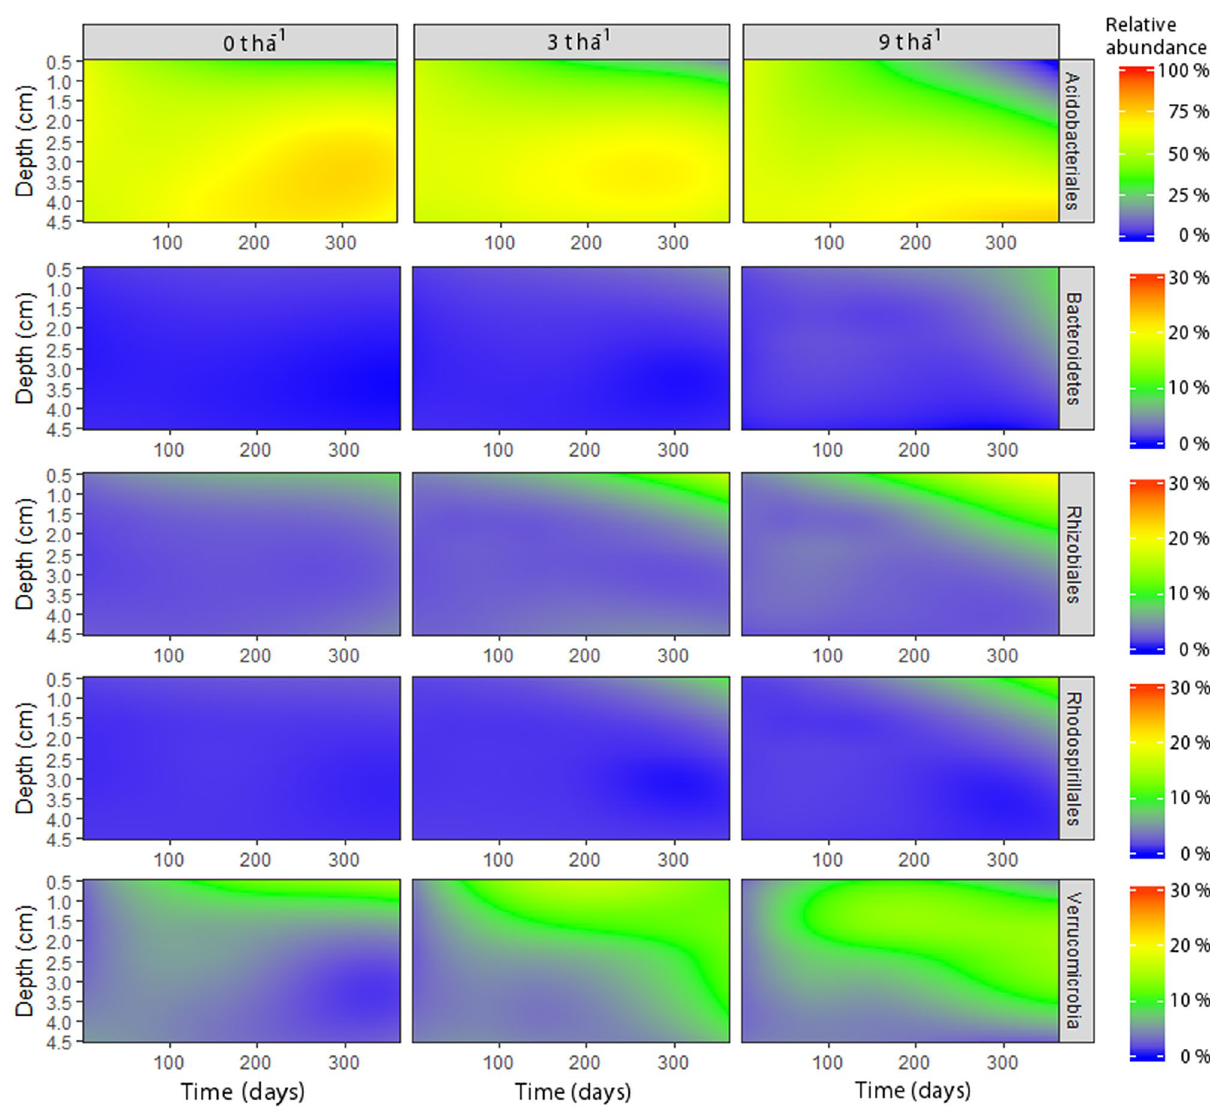
Figure 3. Contour plots of the relative abundance of dominant prokaryotic groups across wood ash concentration, soil depth and time after wood ash application. Colors refer to relative abundance of the groups. Note different color scales between Acidobacteriales and the other presented taxa. Figure was created in R v. 1.0.153 (www.R-proje ct.org) and GIMP v. 2.8.22 (https